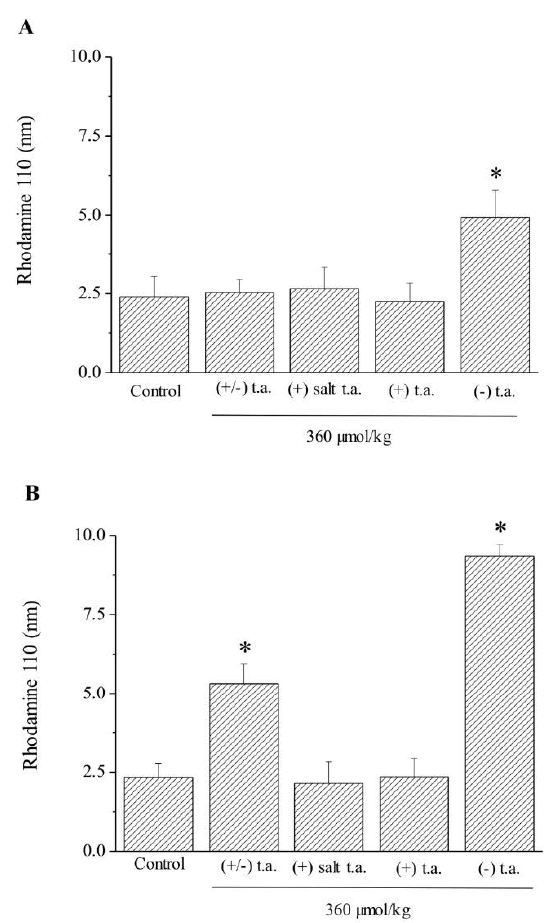
Figure 5. Subchronic toxicity treatments: caspase-3 activity in kidney and spinal cord. E ff ects of 15-day subchronic toxicity treatment with 360- µ mol / kg thioctic acid (t.a.) isoforms (( +/ − ) racemate, ( + ) tromethamine salt enantiomer, ( + ) acid enantiomer, ( − ) enantiomer) on enzymatic activity